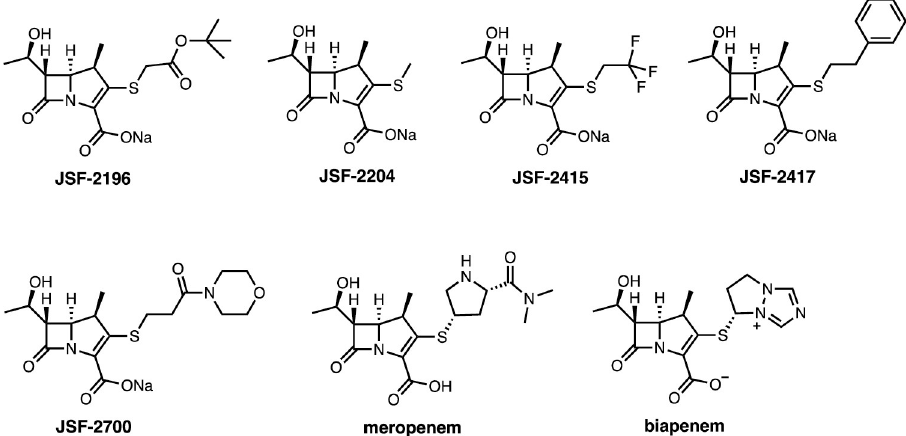
Fig 1. Chemical structures of the carbapenems